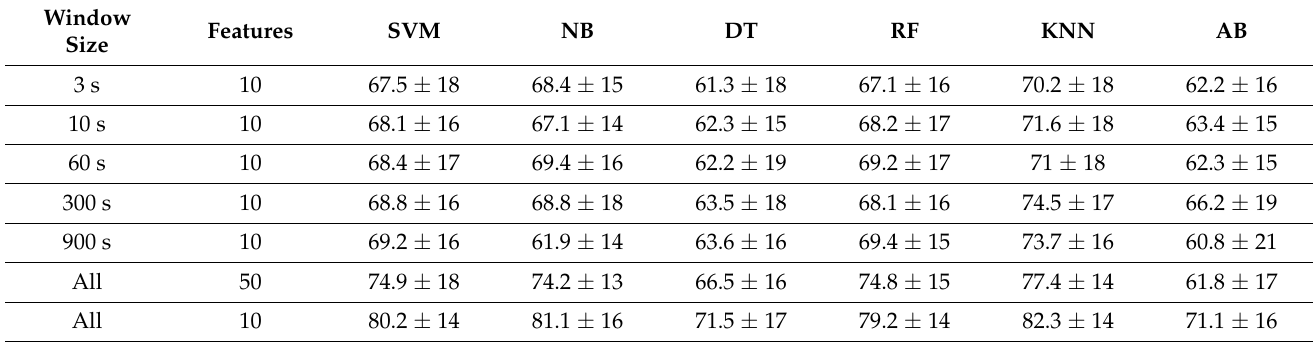
Table 2. Classification of PD vs. HE accuracy values—statistical feature